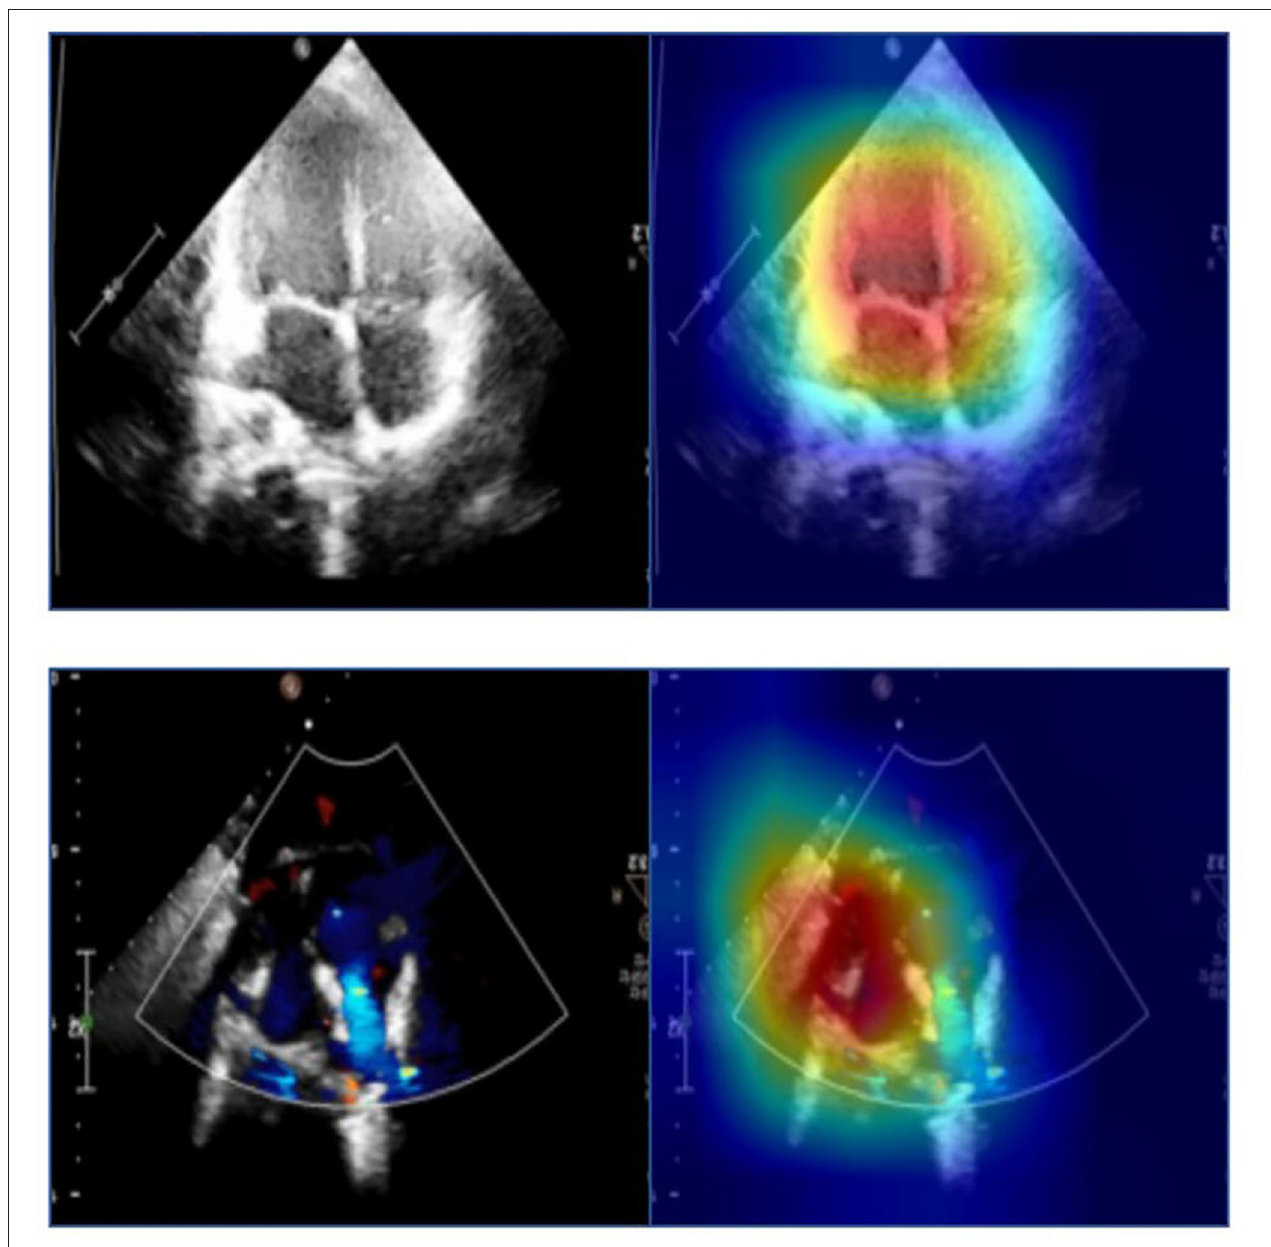
FIGURE 3 | The activation maps of the apical four-chamber view and the subcostal sagittal view of the atrium septum. Different colors in the activation map represent different weights in model prediction. The red part has a higher weight and the blue part has a lower weight. clusters different views, where each point represents an image There are some confusion between subRVOT and of a view in the test data, and its color represents its true view category. Each point in the scatter plot is a two-dimensional projection of the 512-dimensional feature vector generated by the last hidden layer of the model. We observe that most views can be separated well, and only a few clusters are mixed, which means our model can perform generally well on most views. The confusion matrix shown in Figure 5 also demonstrates that the proposed model performs well on most echocardiographic views.